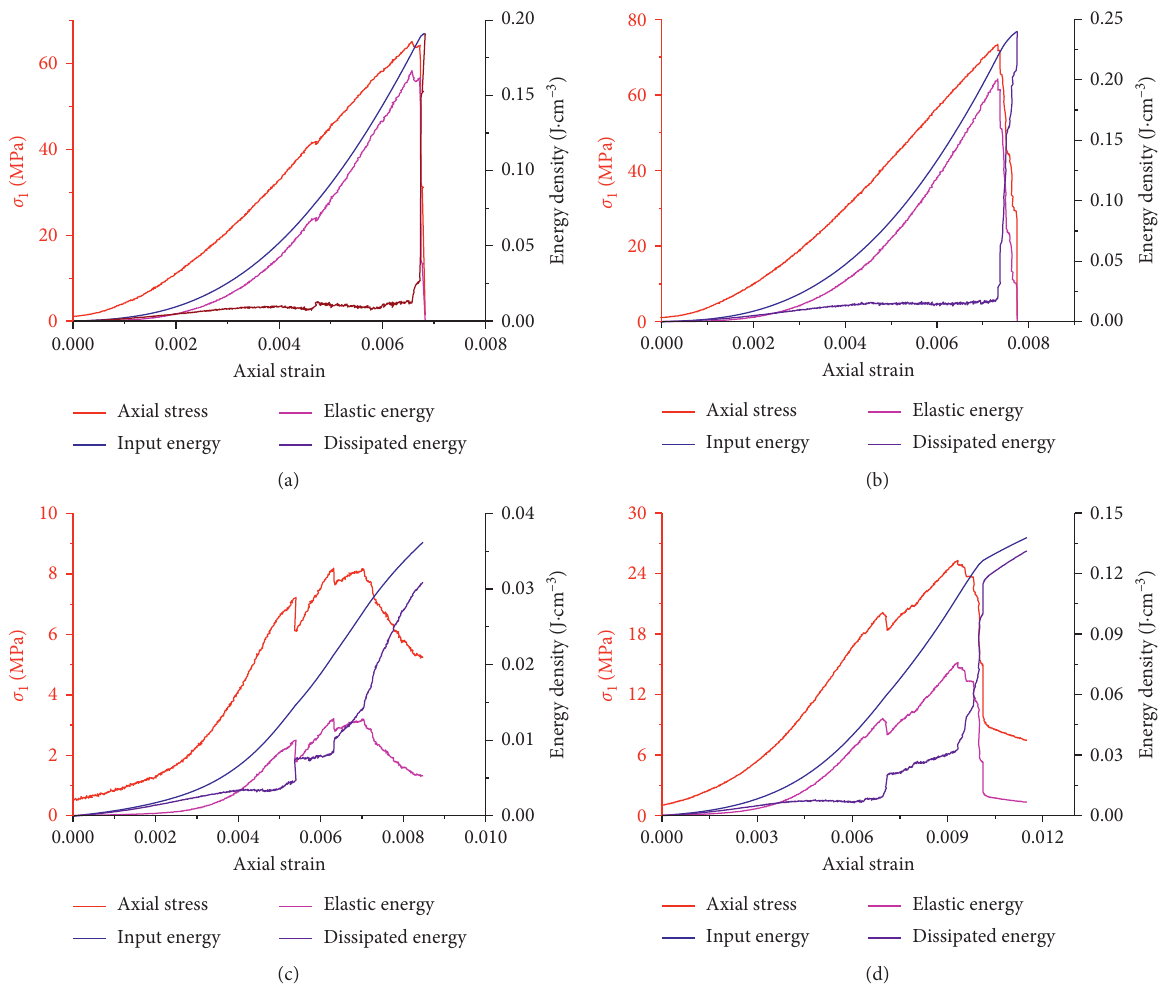
Figure 7: Energy evolution curves of various specimens subjected to uniaxial compression loading. (a) Roof specimen. (b) Floor specimen. (c) Coal specimen. (d) Combined specimen. Table 2: Prepeak energy, postpeak energy, and their ratio under a uniaxial state. Specimen